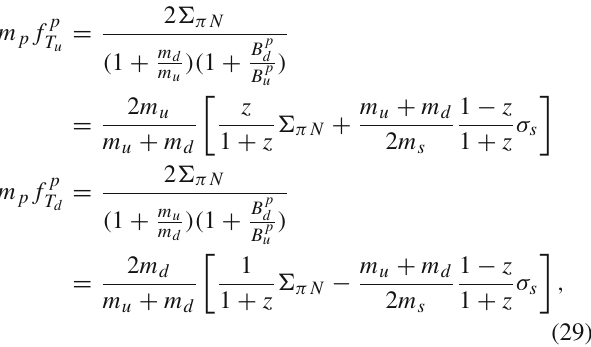
the value inferred from (10) and the older values of (cid:7) π N and σ 0